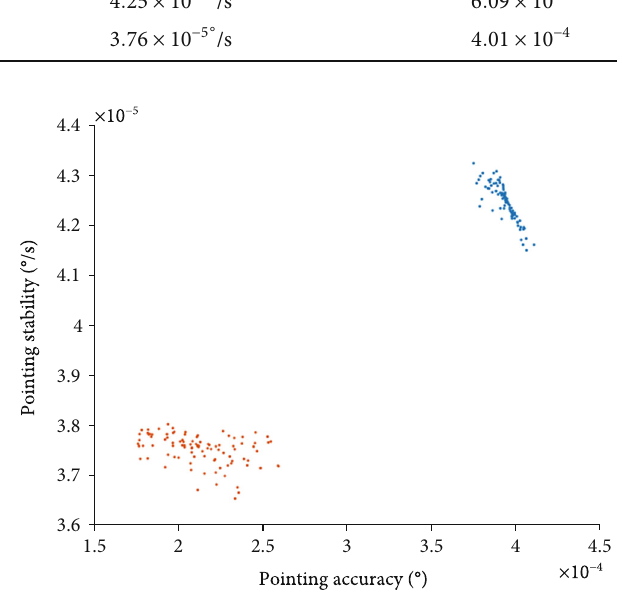
Figure 10: Performance comparison between the PID controller and the neural network